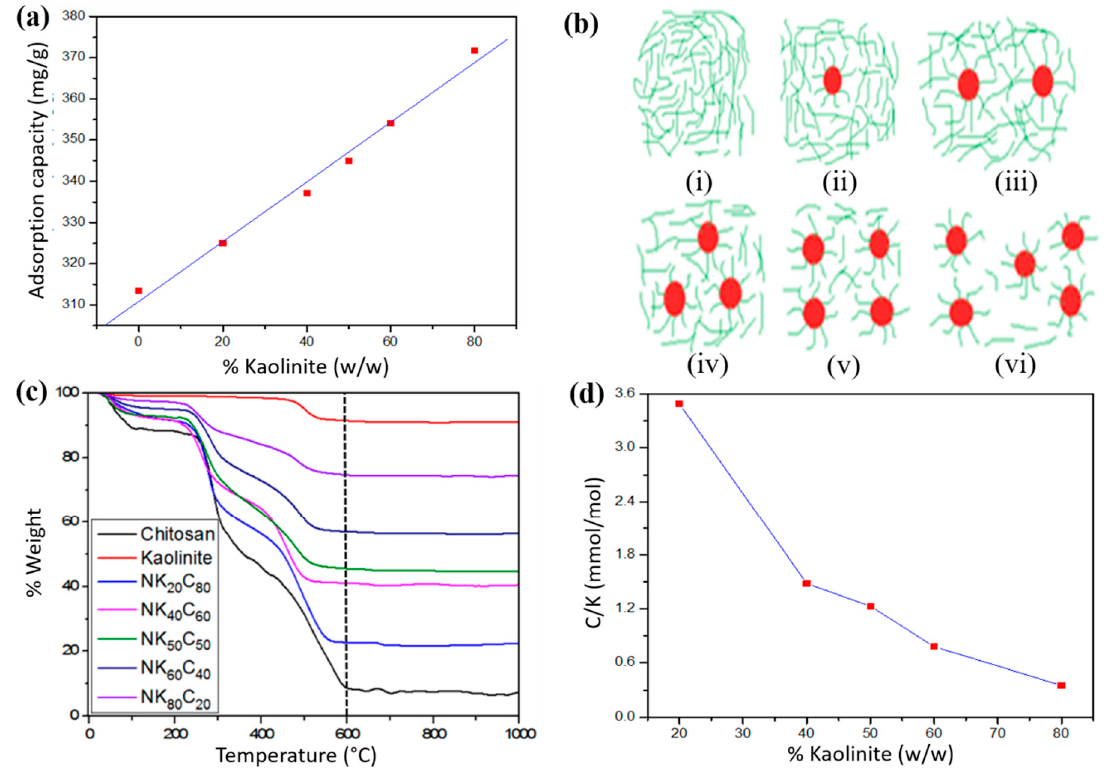
Figure 3. ( a ) Effect of kaolinite content on the adsorption capacity of NCPs; ( b ) proposed interaction between kaolinite and chitosan: ( i ) chitosan, ( ii ) NK 20 C 80 , ( iii ) NK 40 C 60 , ( iv ) NK 50 C 50 , ( v ) NK 60 C 40 , and ( vi ) NK 80 C 20 ; ( c ) thermogravimetric analysis (TGA) thermograms; and ( d ) effect of kaolinite content on the loading of chitosan on kaolinite.